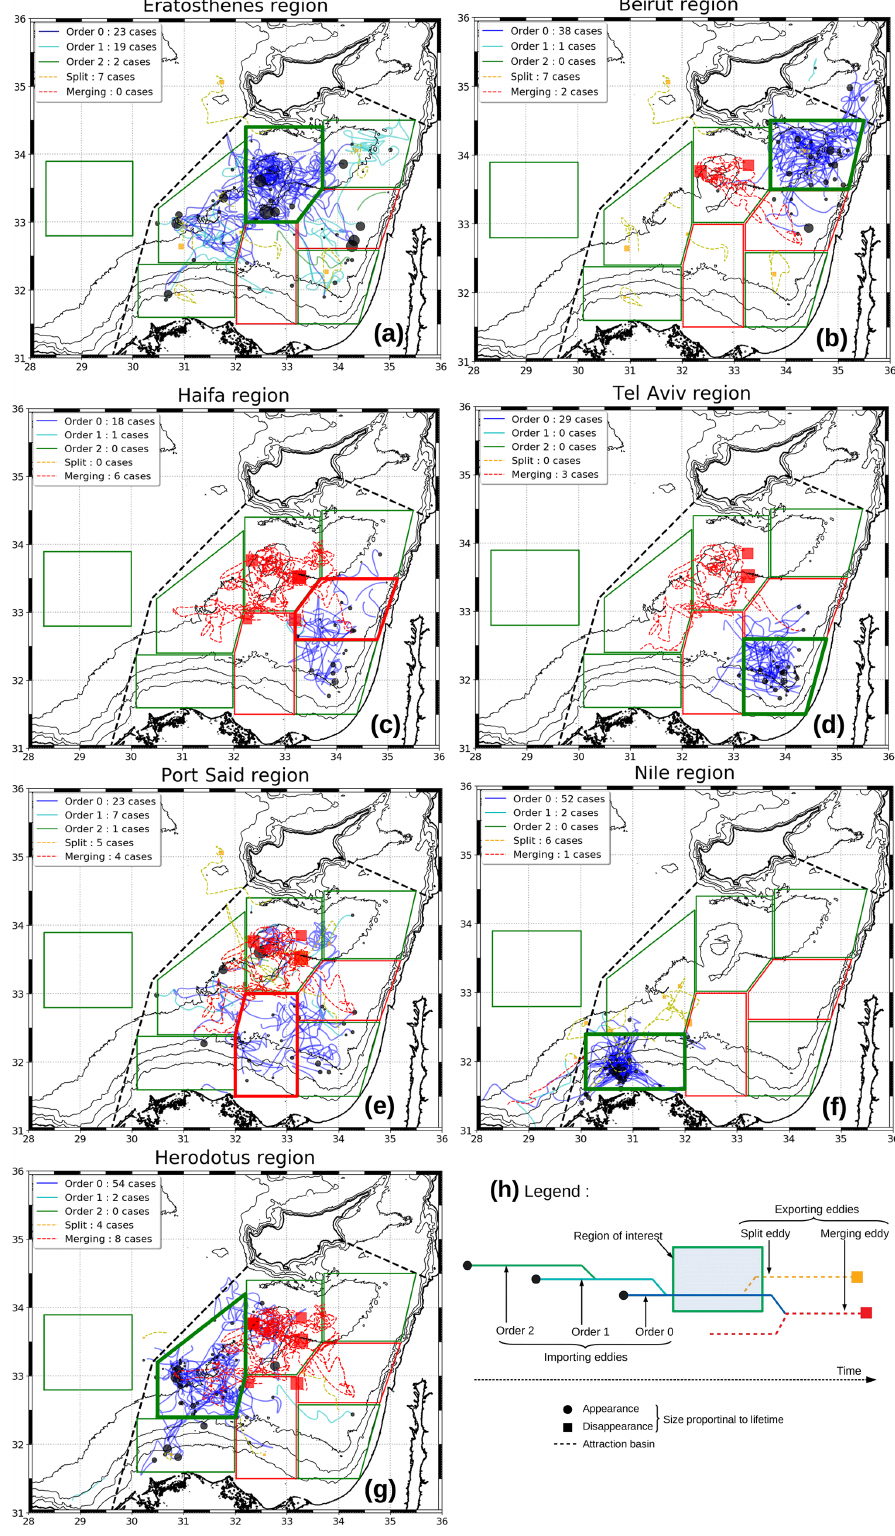
Figure 6. Eddy exchanges framework applied to the (a) Eratosthenes, (b) Beirut, (c) Haifa, (d) Tel Aviv, (e) Port Said, (f) Nile and (g) Herodotus regions. For each panel, all other regions are shown (green borders for AC regions, and red borders for CY regions); the thicker line indicates the study region. The color chart used is summarized in panel (h) . The Marsa Matruh region is studied later in Fig. 10. Ocean Sci., 17, 1231–1250,